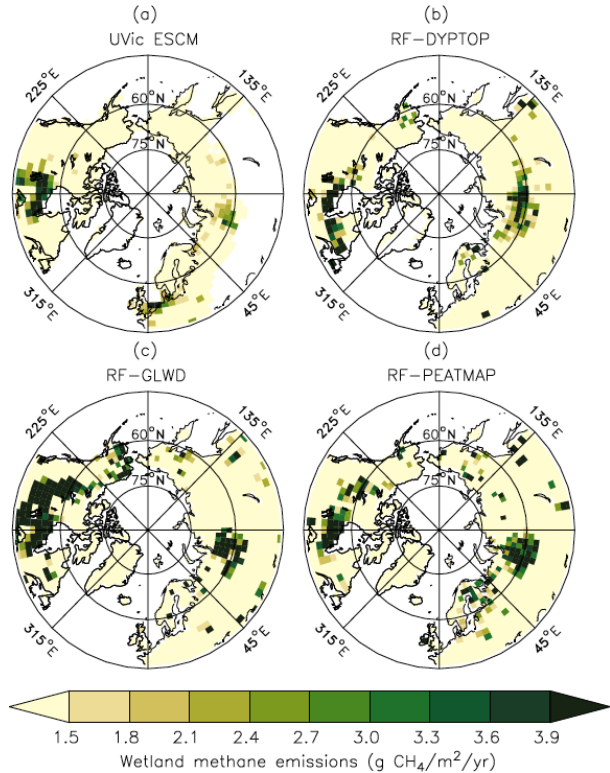
Figure 8. Average CH 4 emissions from wetlands north of 45 ◦ N over the 2013–2014 period as simulated by the UVic ESCM (a) in comparison to three datasets (upscaled flux measurements): (b) RF- DYPTOP, (c) RF-GLWD, and (d) RF-PEATMAP. The datasets are regridded to 3.6 ◦ × 1.8 ◦ for a fair comparison with the UVic ESCM. The comparison period corresponds to the overlap period for the three